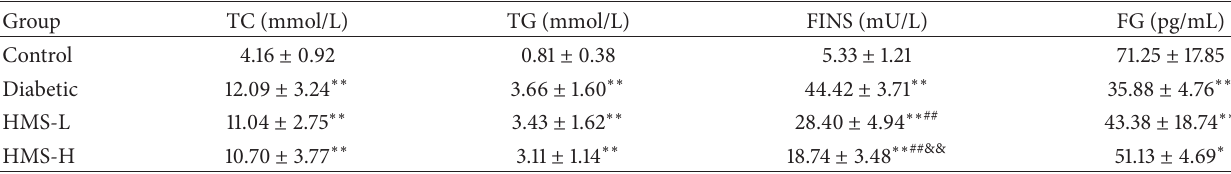
Figure 1: Changes in the fasting blood glucose levels (a) and glucose levels 2h after HMS5552 administration (b) in the rats of the dif- ferent groups. HMS-L group, low-dose (10mg/kg) HMS5552-treated diabetic group; HMS-H group, high-dose (30mg/kg) HMS5552-treated diabetic group. The data are expressed as the mean ± SD ( 𝑛 = 6 ). Table 1: Effects of HMS5552 on biochemical